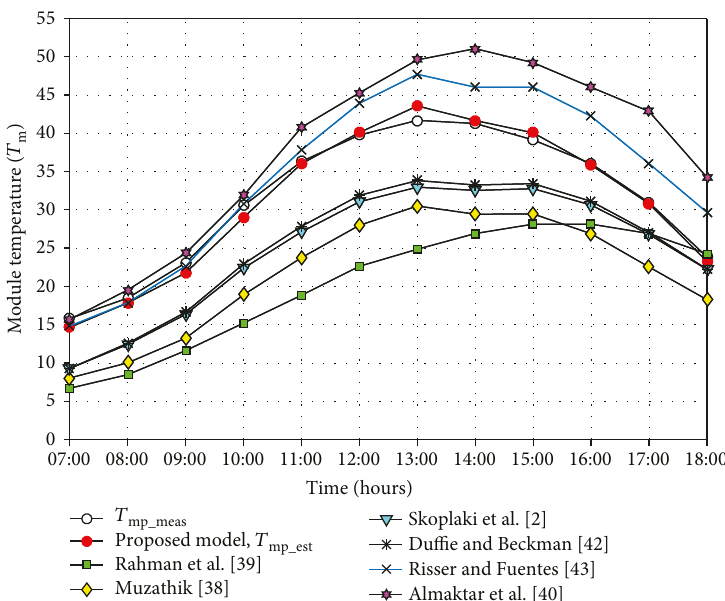
Figure 8: Proposed model estimation versus measured data and other existing model module temperature values of polycrystalline module during winter.